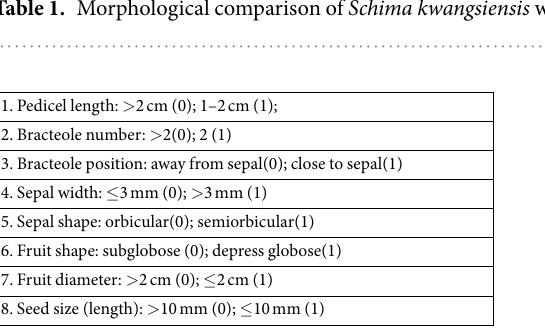
Table 1. Morphological comparison of Schima kwangsiensis with selected fossil and extant species 14, 15 .